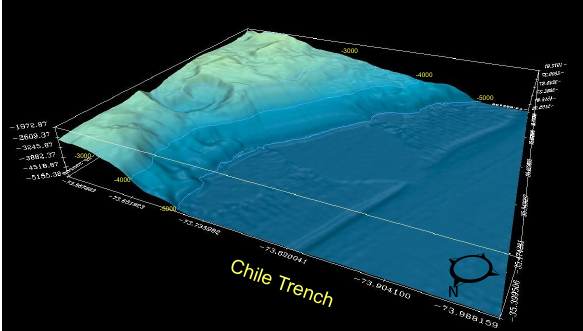
Fig. 4. Perpective view of the restored hypothetical “pre-slump” morphology that was used to calculate missing volumes at the slope and displaced masses in the